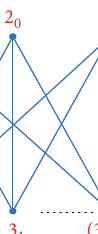
Figure 11: An orthogonal labeling for K